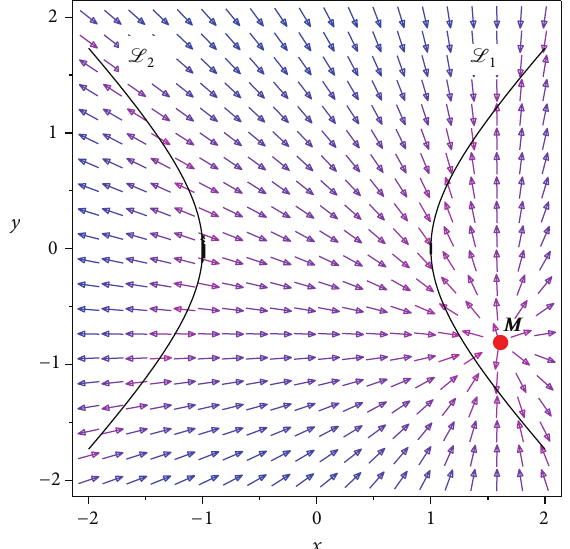
Figure 6: The phase space trajectories of the model with 𝑚 = 1.6 , 𝑛 = 0.8 , 𝛽 = 1 , and 𝜔 = 1/3 . Like Figure 3, this figure is plotted also for the case with 𝑢 = 0 . With these values of parameters, in contrast to Figure 3, the critical line L 1 is stable attractor, while the critical line L 2 remains unstable. Also, in this case, the critical point M is a repeller.